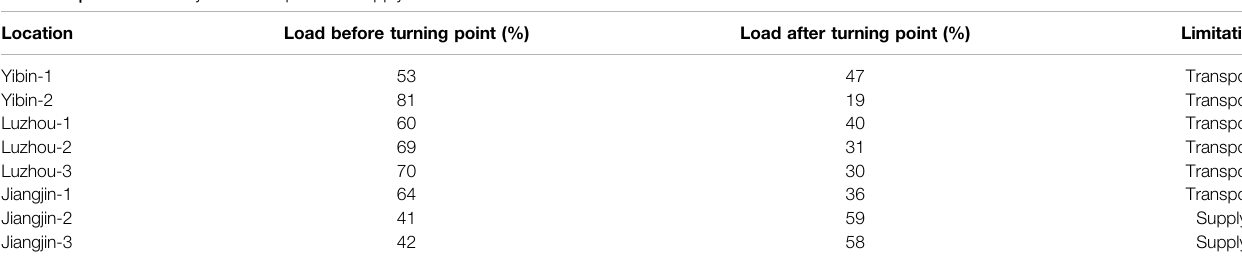
TABLE 9 | Limitation analysis of transport and supply. Location Load before turning point (%) Load after turning point